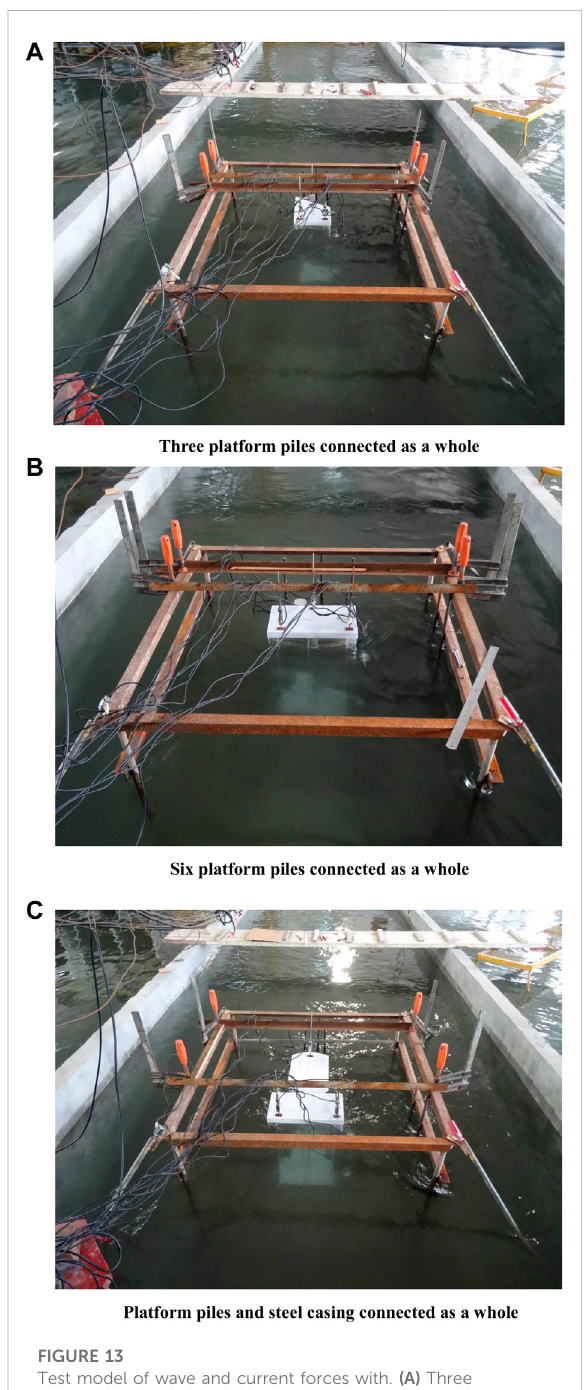
FIGURE 13 Test model of wave and current forces with. (A) Three platform piles connected as a whole. (B) Six platform piles connected as a whole. (C) Platform piles and steel casing connected as a whole.